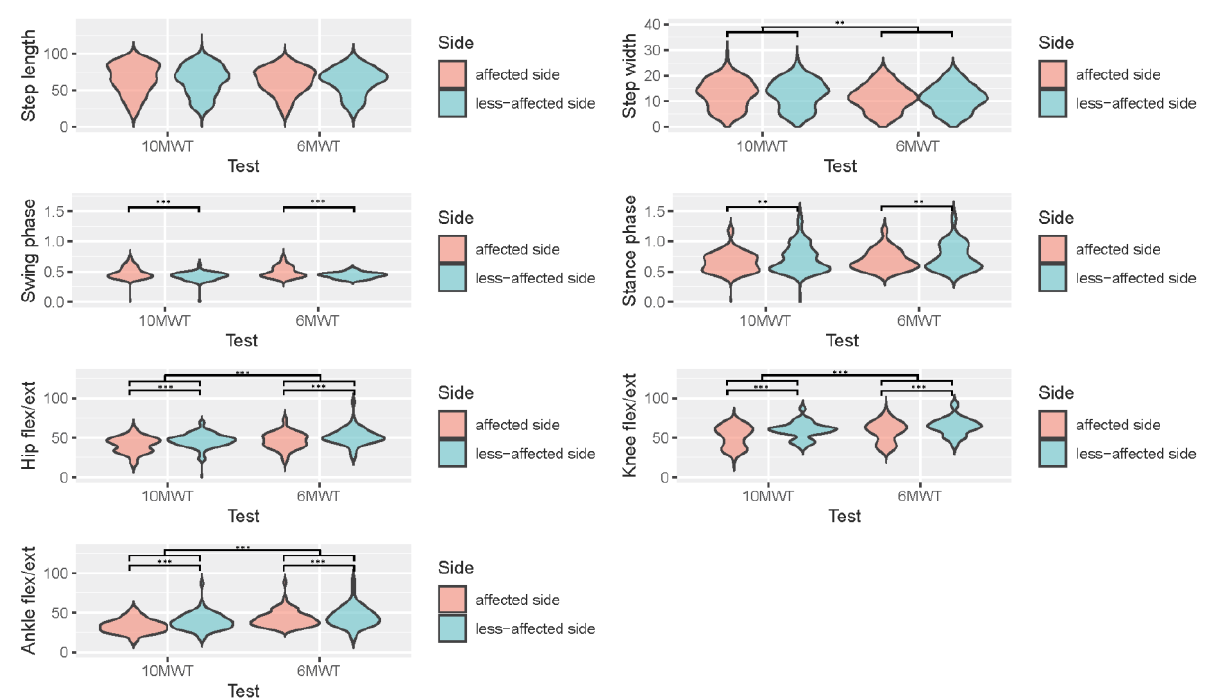
Figure 5. Gait metrics (average step length, step width, swing phase, stance phase duration, and absolute joint ranges of hip, knee, and ankle flexion/extension) differences between legs and be- tween 10MWT and 6MWT. ** indicates statistical significance of p <0.01 and *** indicates statistical significances of p <0.001.